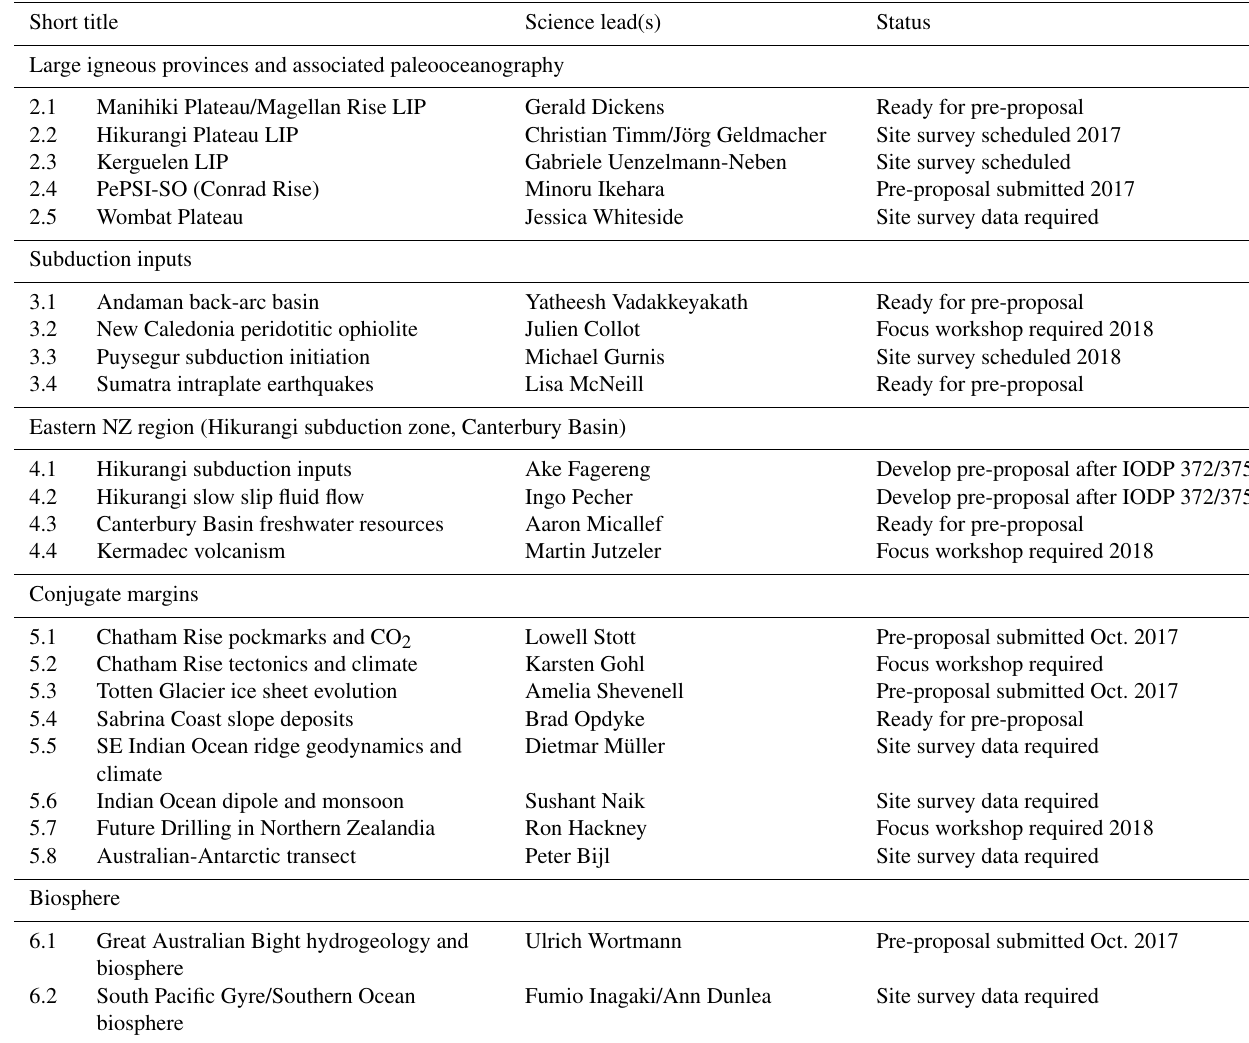
Table 1. List of proposals discussed in the workshop, lead contacts and current status for each proposal. Number relates to section number in main